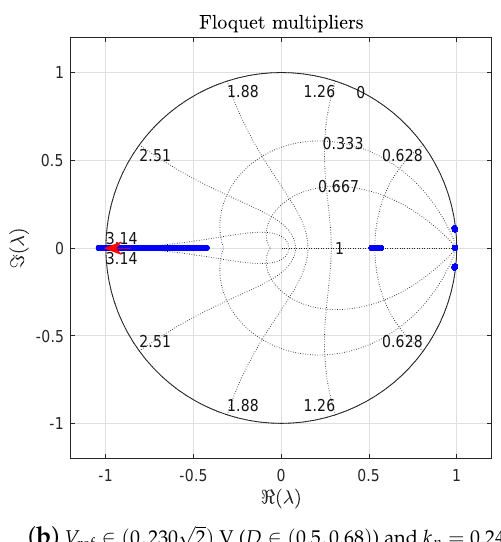
Figure 6. Floquet multipliers loci by varying the quasi-steady-state duty cycle D for two different values of the proportional gain k p